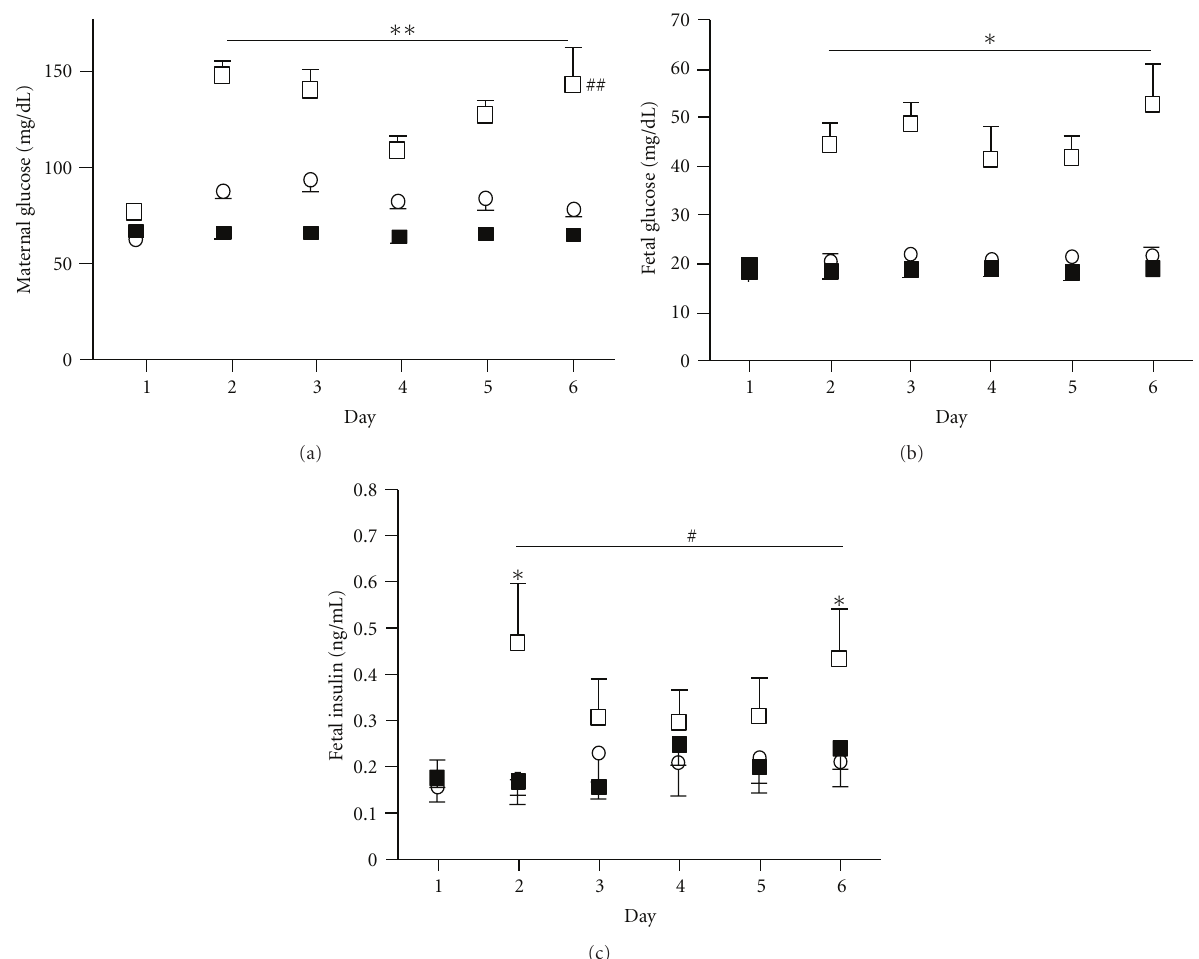
Figure 1: Maternal and fetal glucose and fetal insulin concentrations. Maternal (a) and fetal (b) arterial plasma glucose and fetal arterial plasma insulin (c) concentrations were measured throughout the infusion in CHG ( n = 6, (cid:2) ), PHG ( n = 5, (cid:5) ), and control animals ( n = 7, (cid:3) ). ∗∗ indicates a significant di ff erence between both CHG and PHG from controls for maternal glucose concentrations, P < 0 . 0001. ## indicates a significant di ff erence between CHG and PHG animals for maternal glucose concentrations, < 0.0001. ∗ indicates a significant di ff erence between CHG and both PHG and control groups for fetal arterial glucose and insulin concentrations, P = 0 . 026. # indicates a significant increase in CHG fetuses only compared to their baseline (Day 1) for fetal arterial insulin concentrations, P = 0 .